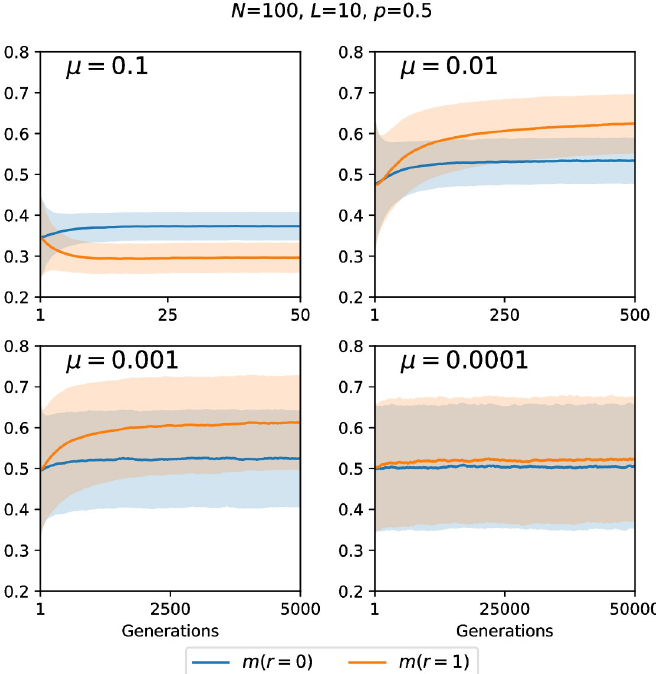
Fig 14. Time evolution of mutational robustness in the fsm . Parameters are N = 100, L = 10, p = 0.5 for different values of the mutation rate μ . Each panel compares obligately recombining ( r = 1) and non-recombining ( r = 0) populations. Thick lines represent the mean over 5000 landscape realizations and the shaded areas the corresponding standard deviation.